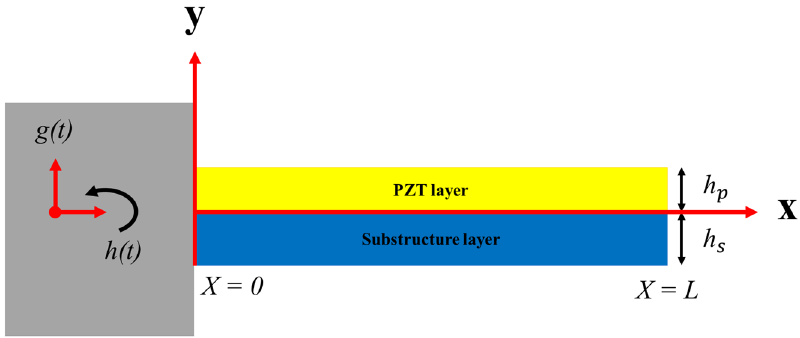
Figure 1. The schematic view of a unimorph cantilever beam.